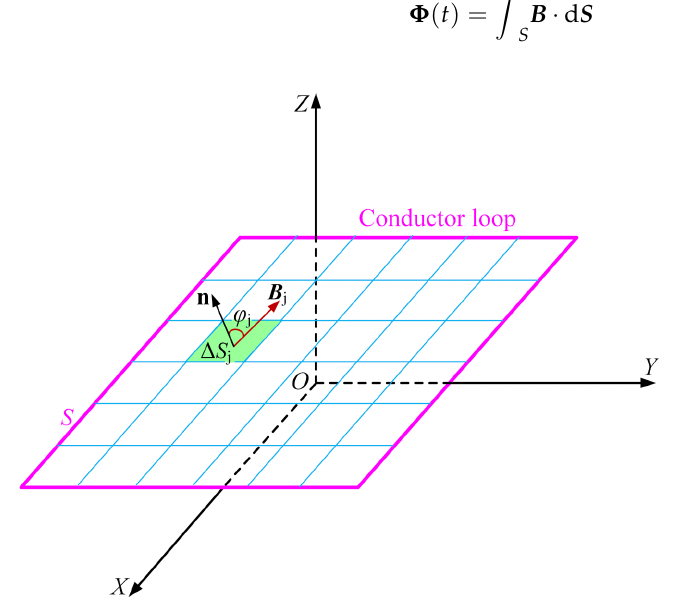
Figure 6. Subdivision for conductor loop